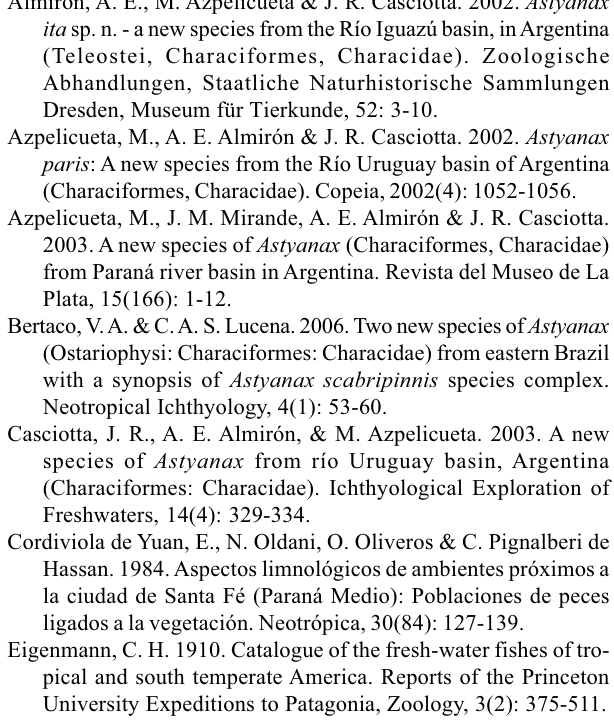
de Figueroa. Astyanax saguazu : MLP 9603, holotype, 63.0 mm SL, Misiones, río Uruguay basin, arroyo Once Vueltas. Astyanax stenohalinus : AI132, 2 c&s, 42.6-55.7 mm SL, Buenos Aires, Punta Indio, unnamed stream, Río de la Plata basin. Astyanax troya : MACN 8310, holotype, 73.8 mm SL, Misiones, arroyo Cuñapirú Chico, río Paraná basin. Astyanax tupi : MACN-Ict 8646, holotype, 70.1 mm SL, Misiones, arroyo Cuñapirú Chico. Paraguay: Ctenobrycon alleni : CAS 57616 (IU10158), holotype, 80.0 mm SL, Asunción, Corumba, río